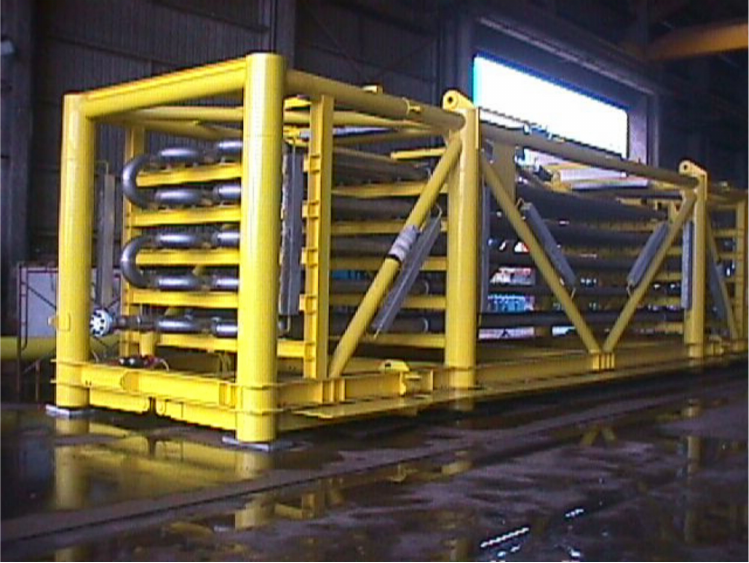
Figure 13. Subsea heat exchanger in superduplex stainless steel with anodes for external corrosion protection.